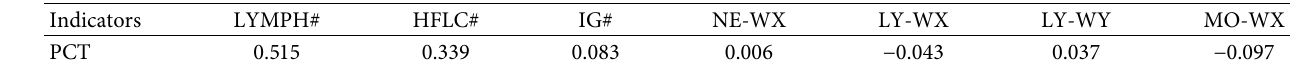
Table 5: Correlation between leukocyte parameter and PCT ( R ).